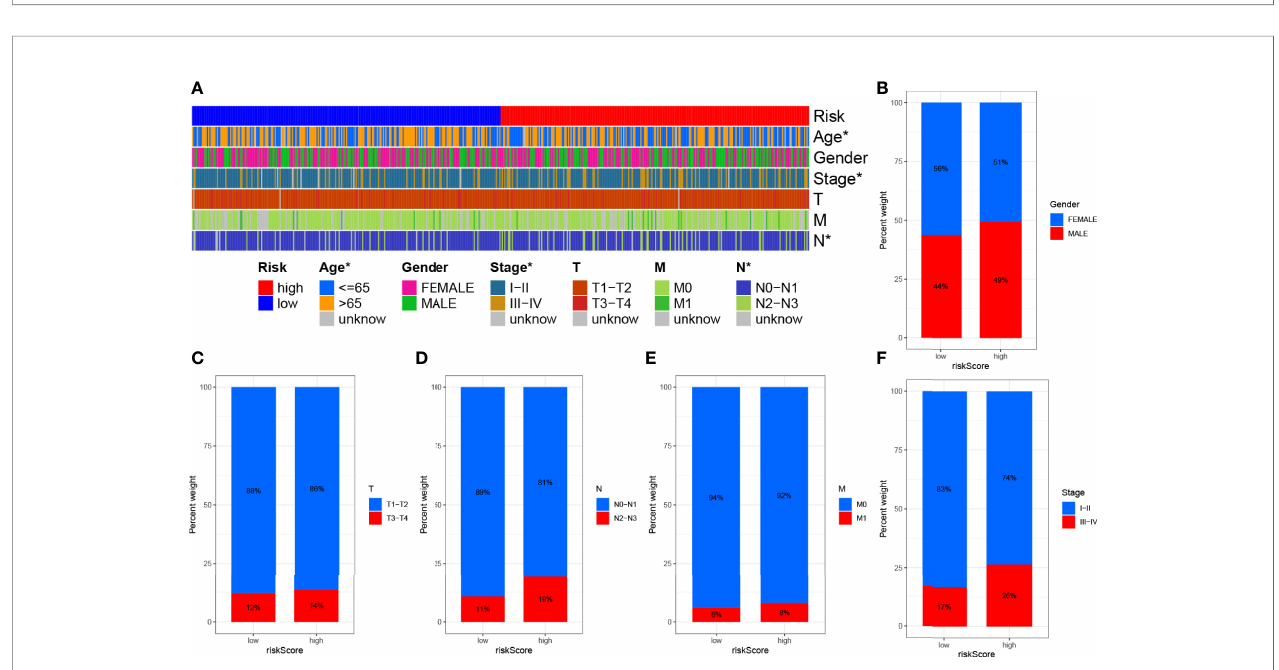
FIGURE 6 | Clinical signi fi cance of prognostic risk characteristics. (A) Heatmap showing the distribution of clinical characteristics and corresponding risk scores in each sample. Incidence of clinical variable subtypes of LRG/HRG. (B) Gender, (C) stage T, (D) stage N, (E) stage M, and (F) clinical stage.